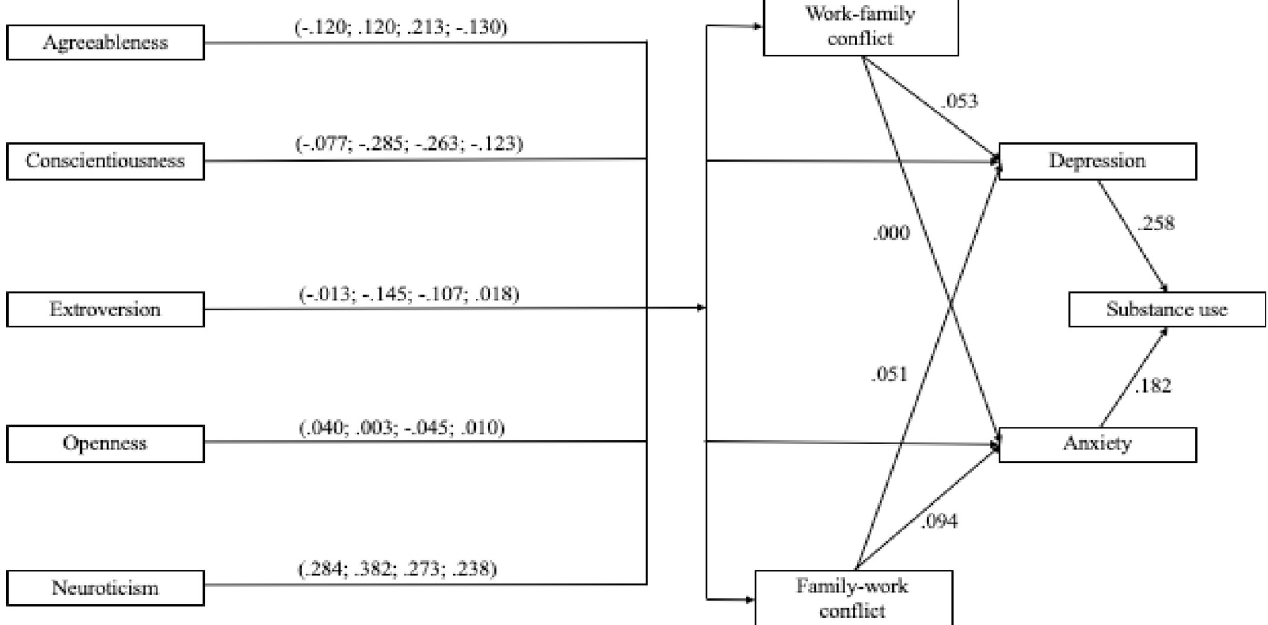
Fig 3. Model of statistical results. Path coefficients resulting from mega-meta path analysis. Note . Values in parentheses indicate direct paths from each trait to work-to-family conflict, depression, anxiety, and family-to-work conflict in that order. Paths > .020 are statistically significant. For clarity, the intercorrelations between the Big Five traits and the correlations between the disturbance terms for the endogenous variables are omitted.